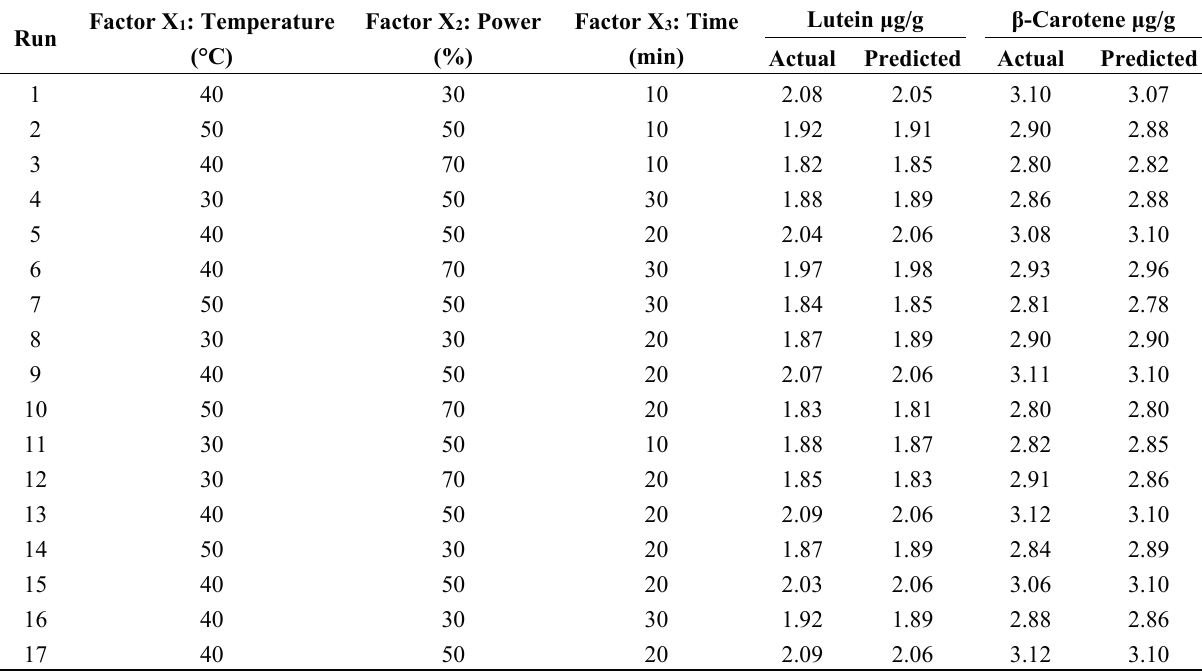
Table 1. Summary of independent variable settings of ultrasonic treatments for Box-Behnken design, amounts of lutein and β -carotene extracted from spinach, and predicted values based on RSM model.